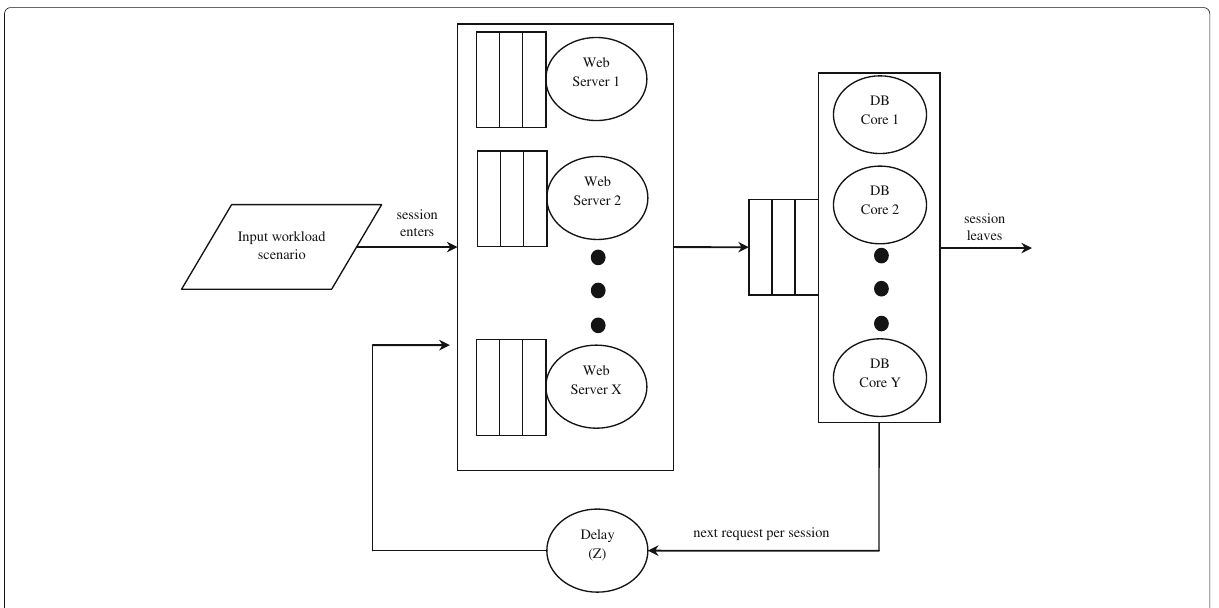
Fig. 4 WAM model of a two tier application